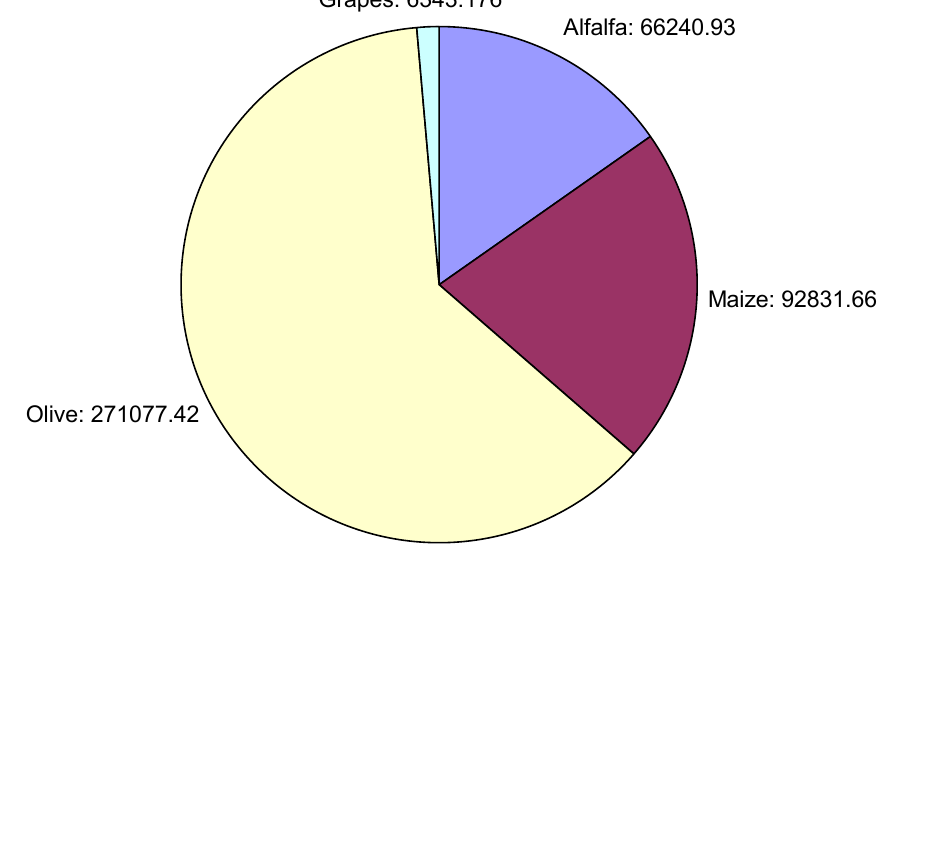
Figure 9. Water volume (m 3 yr -1 ) that is required per crop in Thermo